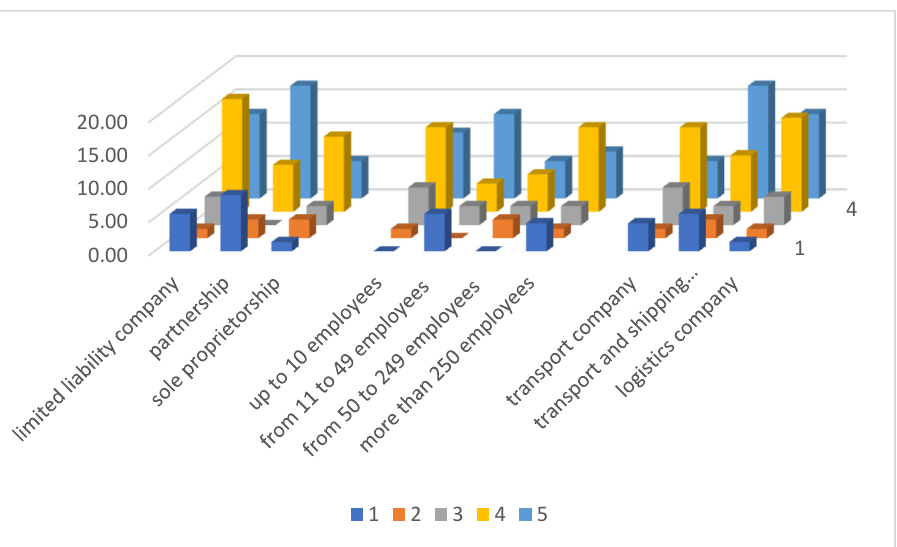
Figure 7. Availability of fast charging points at motorways and expressways and demand for electric vehicles—criteria organisational and legal form, employment structure, scope of activity .